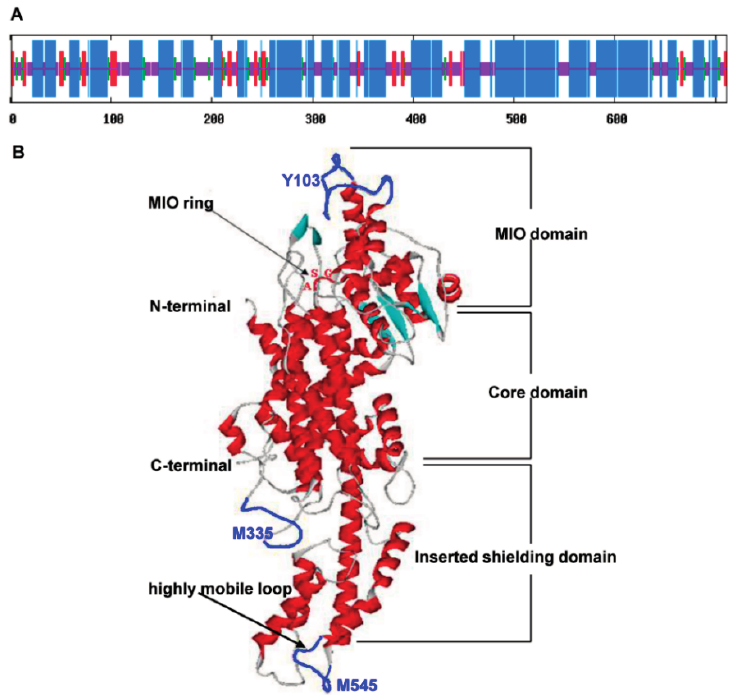
Figure 3. Predicted molecular model of SsPAL1 . ( A ) Predicted secondary structure of SsPAL1 . The red, green, blue and pink regions represent the extended strand, beta turn, alpha helix and random coil, respectively; ( B ) Predicted tertiary structure of SsPAL1 . The α -helices, β -sheets, turns and coils are shown in red, cyan, dark and white, respectively. The MIO ring, Ala-Ser-Gly, is marked red. The highly-mobile loops at residues 103, 335 and 545 are